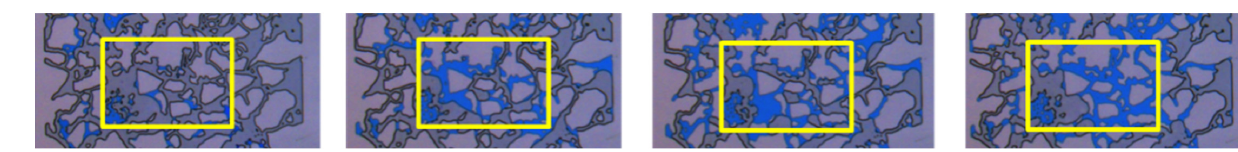
Figure 10. The distribution of retained water phase in porous media when the gas injection pressure is changed, 200 μ m.